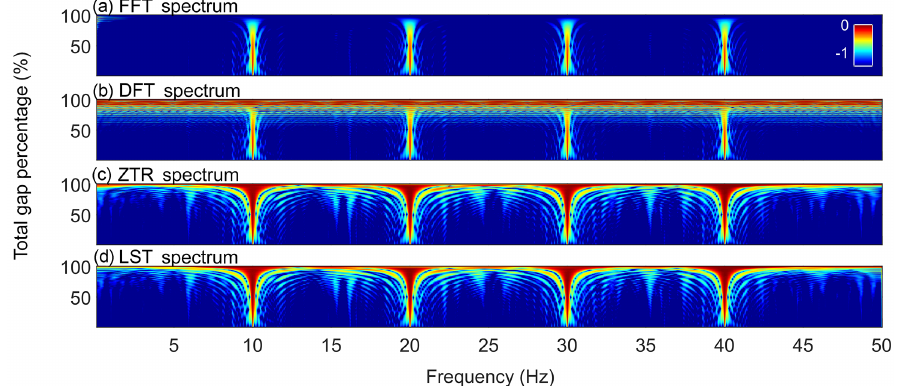
Figure 4. SLG test applied to the synthetic data: amplitude in color code as a function of TGP and frequency. For the SLG test, we generate 100 signals, indexed from 1 to 100, with signal 1 corresponding to the signal with the smallest TGP and signal 100 to the one with the highest TGP. For SLG, the TGP is a linear function of signal index. Panels (a) , (b) , (c) and (d) show the results for FFT, DFT, ZTR and LST. Color scale is logarithmic and the color bars denote the log10 of amplitude.